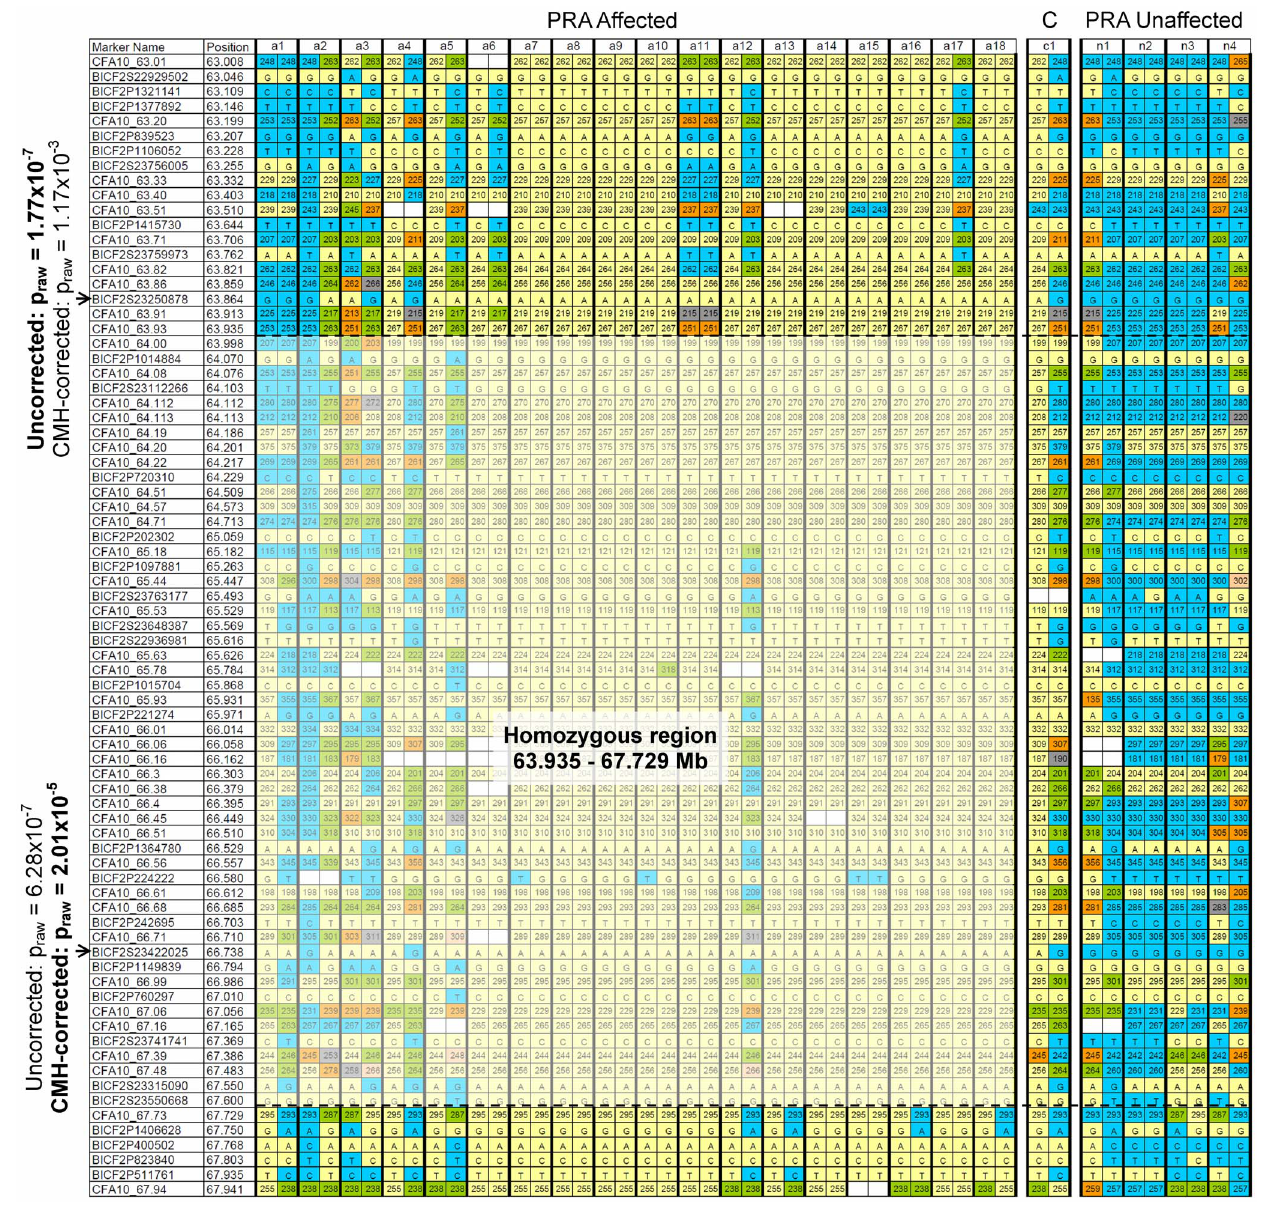
Figure 2. Critical region definition using homozygosity analysis. Microsatellite and SNP marker genotypes for 18 PRA cases and five PRA controls (including one obligate carrier) over the region identified during the GWA study. It is not possible to define a region for which all of the cases are homozygous, however, it is possible to define a broad region for which most of the cases (12/18) are homozygous, from 63.935 to 67.729 Mb. The most associated SNP markers are indicated with arrows ( R